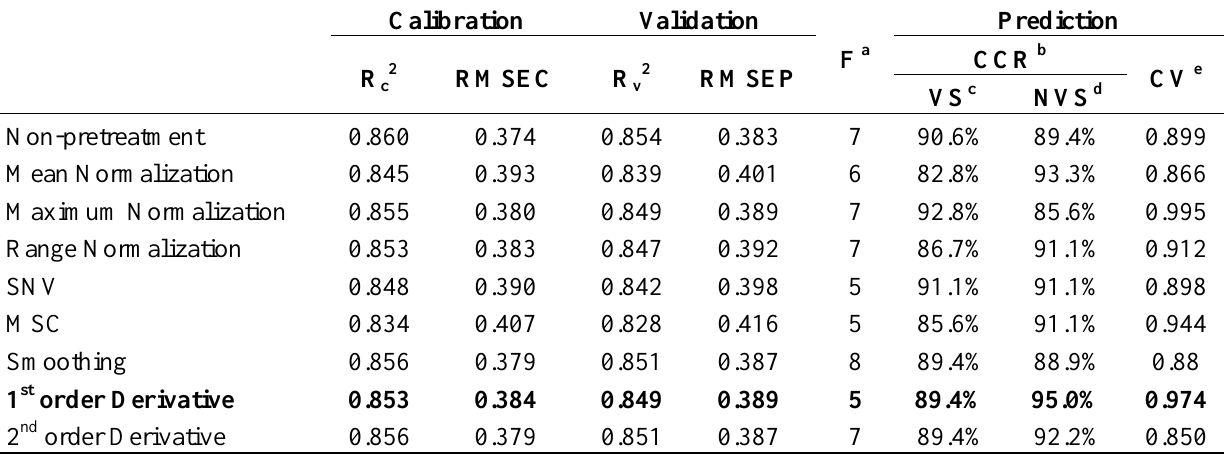
Table 1. Results obtained using the PLS-DA models based on the reflectance spectra with BL illumination (400–500 nm).